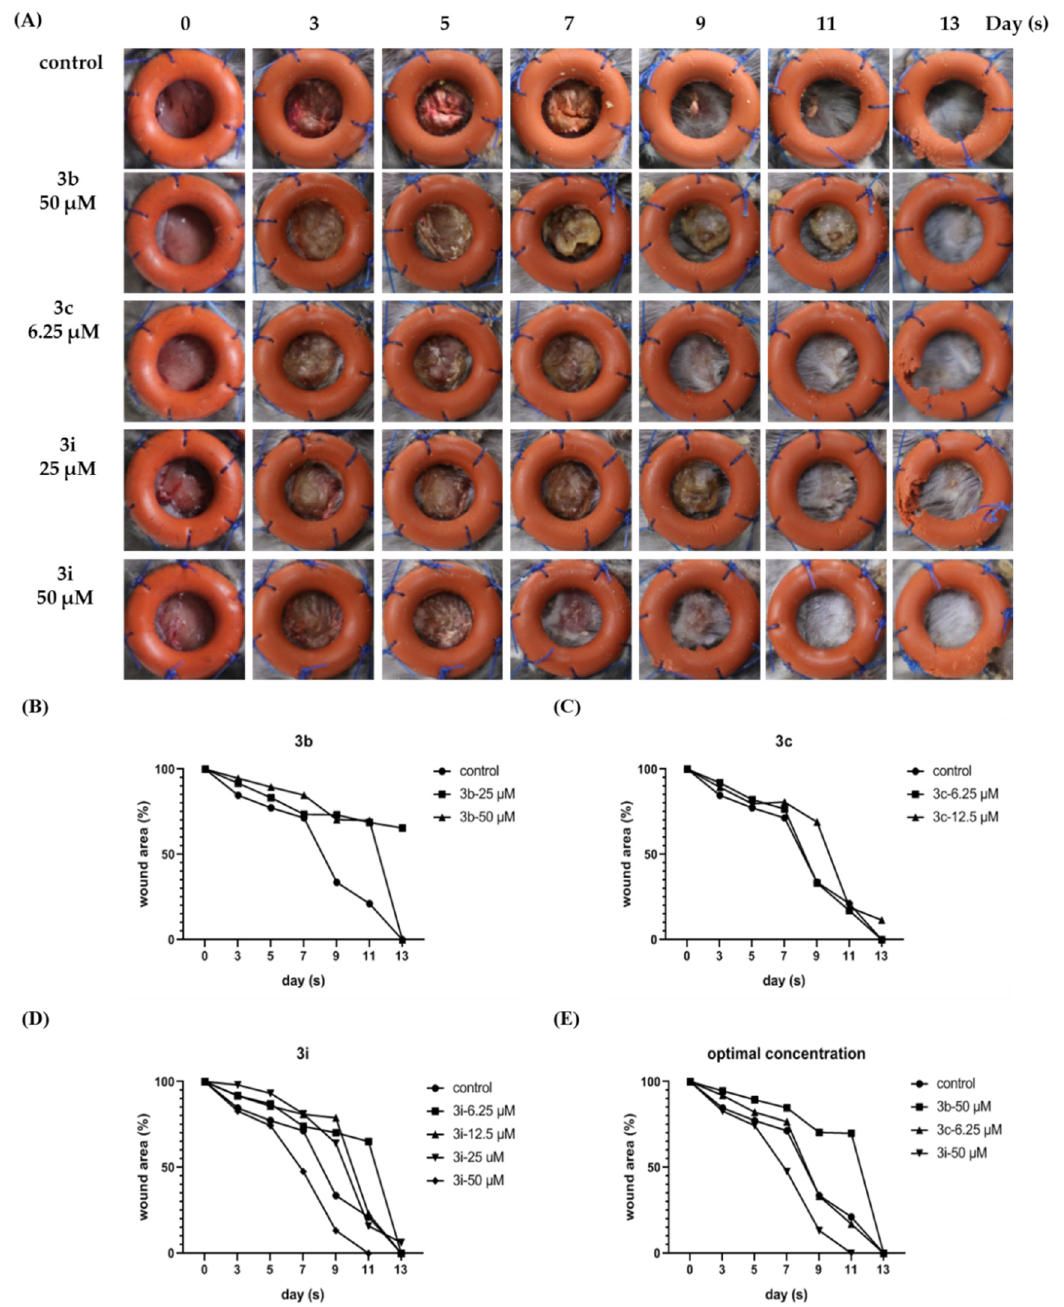
Figure 4. ( A ) The closure of mouse wounds treated with empty fibrin gel (control) or fibrin gel containing 3b , 3c , and 3i . Representative pictures of the wounds are shown at days 0, 3, 5, 7, 9, 11, and 13. Wound closure progression during treatment with ( B ) 3b , ( C ) 3c , and ( D ) 3i . ( E ) Comparison of the effects of the optimal concentrations of 3b , 3c , and 3i on wound healing. 3b , 3c , and 3i are arranged in accordance with the specific concentration of each compound that was used in a gel applied to wounds in mice once per day for a total of 13 days.